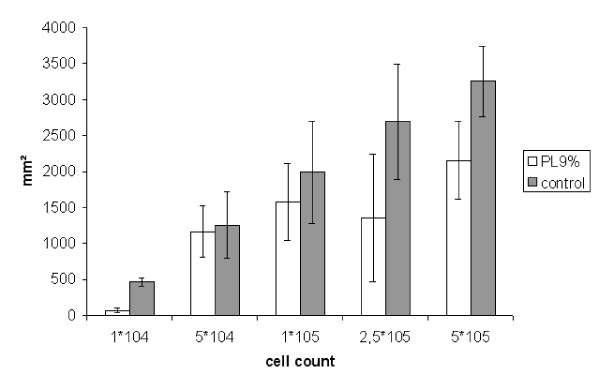
Experiment B: Area of tumor adhesion (mm2, SEM). (1*104 p = 0,001; 5*104 no significance; 1*105 no significance; 2,5*105 p = 0,0032; 5*105 p = 0,0013)